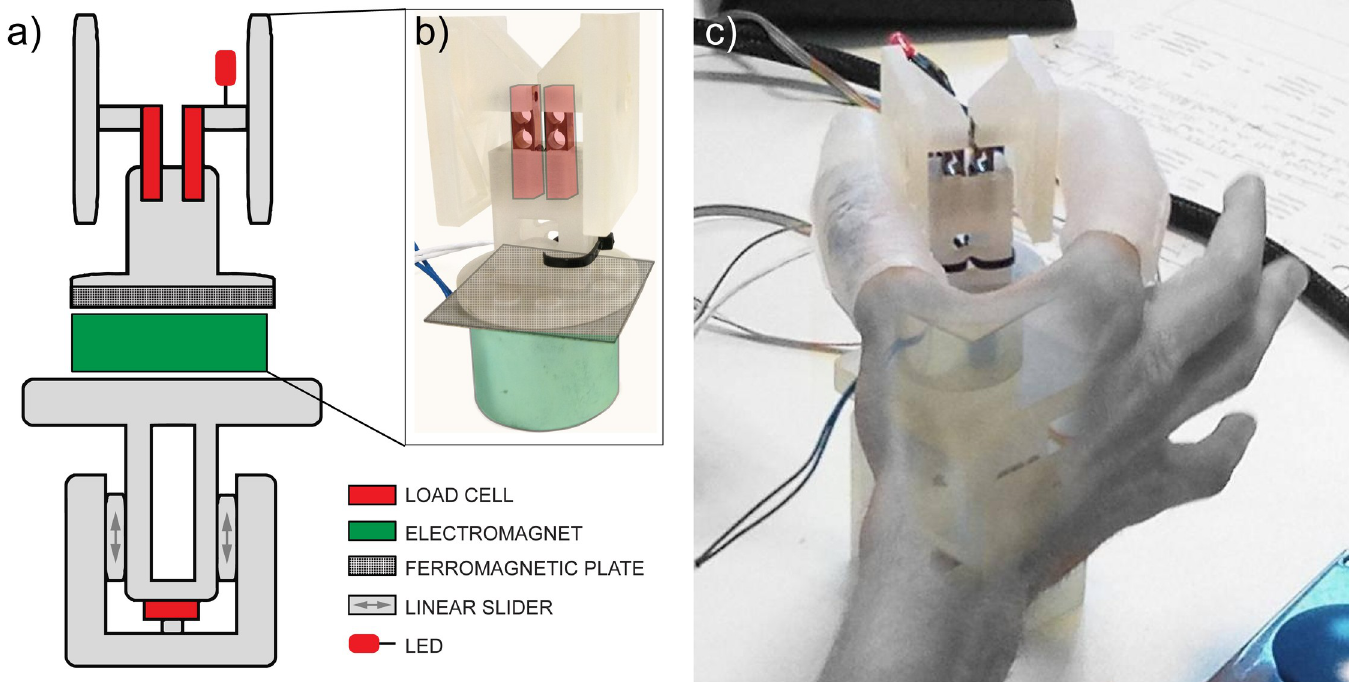
Fig 1. Sketch and photos of the instrumented test object with optional weight and the digit extensions. The weight was a non-ferromagnetic electromagnet that could be switched on without the participant’s knowledge and latched on to the underside of the object (green in sketch a). Two load cells measured the forces perpendicular to the grasping surfaces. The object stood on a platform that measured the lifting force (perpendicular to the table) until liftoff with another load cell. Sketch (a) also shows the LED. Photo (c) shows the object being grasped by a participant wearing the silicone digit extensions.